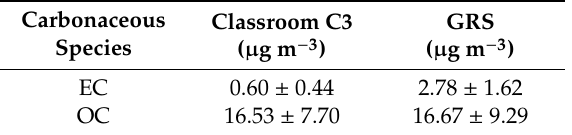
Table 3. Average values of organic carbon (OC) and elemental carbon (EC) within classroom C3 and on the GRS for the entire experimental